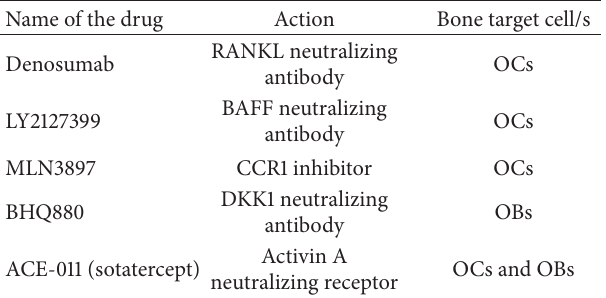
Table 1: Novel drugs for multiple myeloma bone